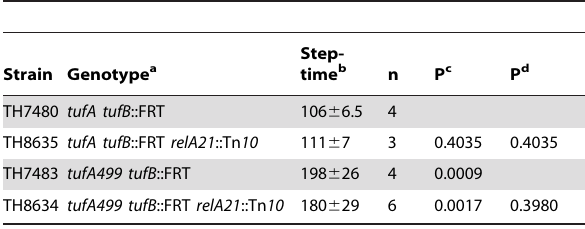
Table 3. Inactivating relA does not alter step-time of the tufA499 mutant.